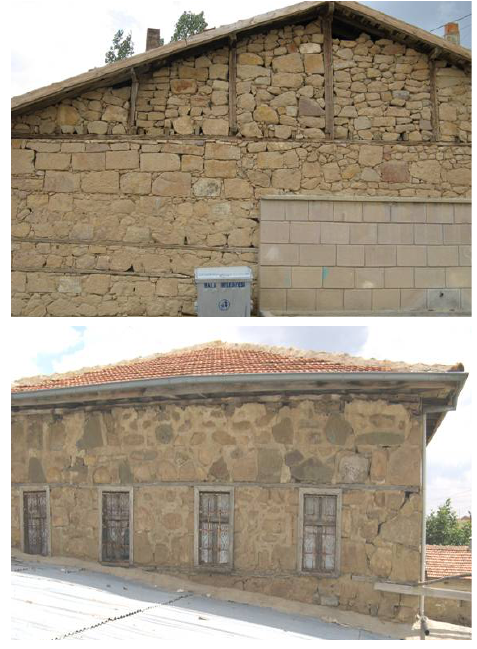
Fig. 11. Examples of masonry buildings formed by horizontal wooden bond Fig. 11 Examples of masonry buildings formed by horizontal wooden bond beams